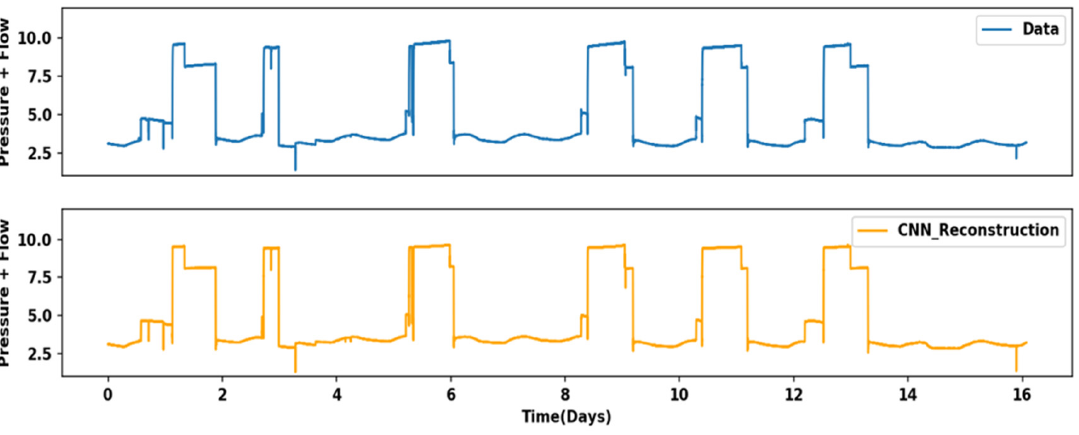
Figure 9. CNN autoencoder in working conditions: detection result graph.